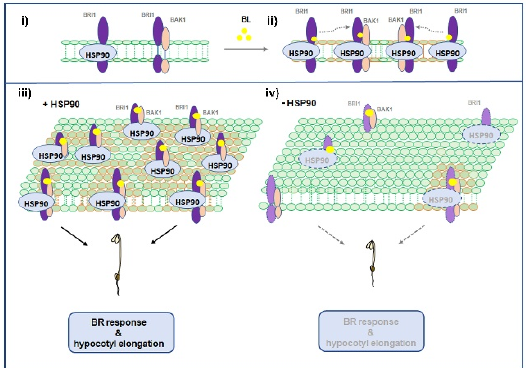
Figure 7. Proposed model for the function of HSP90 in the activation of BRI1 at the plasma membrane. In resting conditions, BRI1 associates with HSP90.1, and this interaction prevents the association of BRI1 to BAK1, as it was demonstrated by the sequestration of the two complexes at the PM. HSP90.1 association with BRI1 keeps the latter poised for activation, since in the presence of ligand (BL) HSP90.1-bound BRI1 incorporates in the BRI1/BAK1 heterocomplexes, which is deduced by their similar PM localizations. Interaction assays of HSP90.1 and BAK1 with truncated forms of the BRI1 receptor showed that although BRI1 kinase activity does not seem to depend on HSP90 ATPase function, it modulates the changes in the partitioning of HSP90.1/BRI1 and BRI1/BAK1 complexes at the PM and mediates the integration of HSP90.1 bound BRI1 into a complex with BAK1 co-receptor. ( i ) In the absence of the active ligand HSP90 interacts with BRI1, while partitioning of HSP90-bound BRI1 receptor is distinct from the partitioning of BRI receptor associating with its co-receptor BAK1 at the plasma membrane. ( ii ) Upon ligand activation the plasma membrane distribution of both HSP90-bound BRI1 and BAK1 associating BRI1 are similar suggesting the incorporation of HSP90-bound BRI1 to activated heterocomplexes with BAK1. ( iii ) In the presence of HSP90, ligand activation leads to increased abundance of BRI1 and to symmetric distribution of the activated BRI1-BAK1 heterocomplexes at the plasma membrane, which mediates the initiation of the downstream signaling cascade that controls BR response. ( iv ) Upon depletion of HSP90, the presence of active ligand does not increase the levels of BRI1 at the plasma membrane and the spatial sequestration of HSP90-bound BRI1 from the BRI1/BAK1 heterocomplexes at the plasma membrane, is enhanced leading to the attenuation of the downstream BR signaling and response.